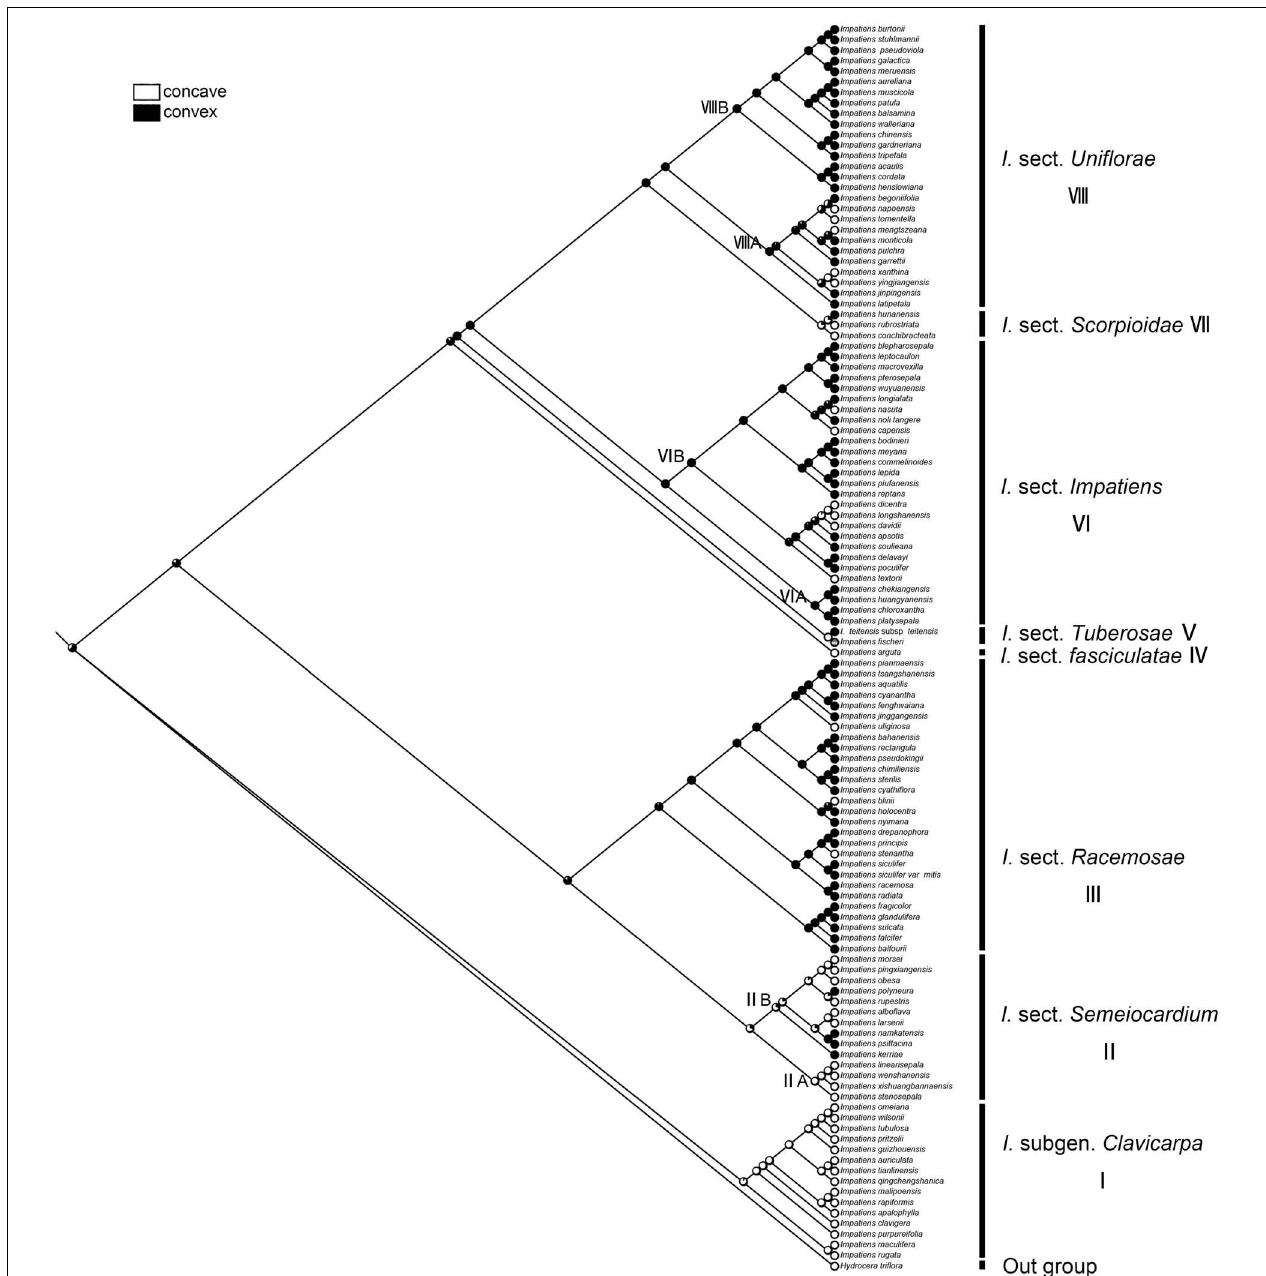
FIGURE 10 | Ancestral reconstruction of the periclinal cell wall in Impatiens using ML. Two characteristic states of periclinal cell of Impatiens optimized on the BI tree by using different